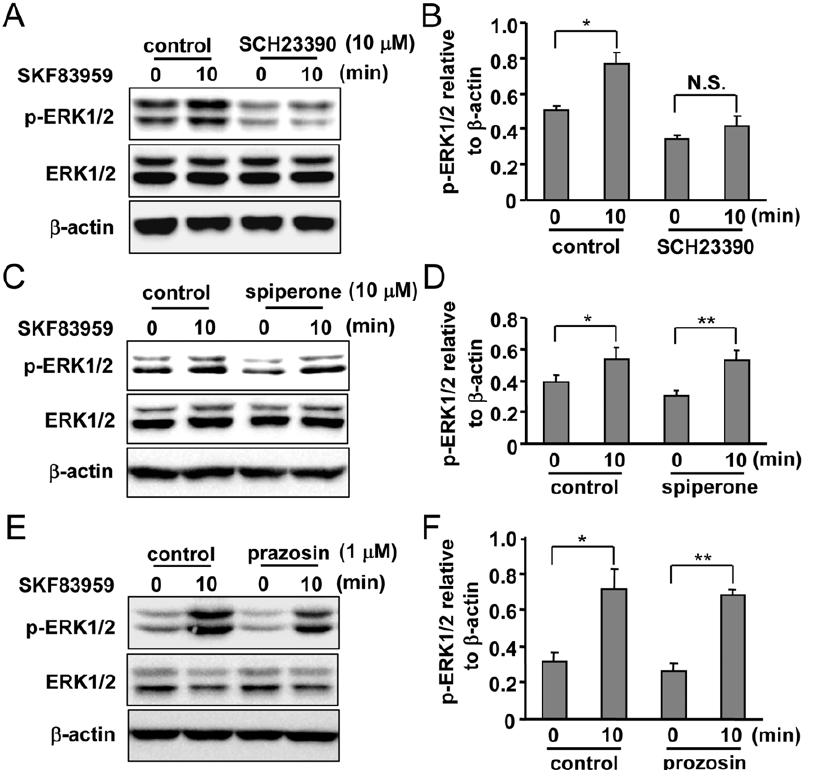
Figure 2. Involvement of putative PI-linked D 1 -like receptors in SKF83959-induced ERK1/2 phosphorylation. (A) Effects of D 1 dopamine receptor antagonist SCH23390 (10 m M, 30 min) on SKF83959 (30 m M, 10 min)-induced ERK1/2 phosphorylation. (B) Quantification of ERK1/ 2 phosphorylation level in astrocytes pre-incubated with SCH23390 and treated with SKF83959 (Mean 6 S.E., n=3, * P , 0.05, 10 min vs. 0 min). N.S.: no significance. (C) Effects of D 2 receptor antagonist spiperone (10 m M, 30 min) on SKF83959 (30 m M, 10 min)-induced ERK1/2 phosphorylation. (D) Quantification of ERK1/2 phosphorylation level in astrocytes pre-incubated with spiperone and treated with SKF83959 (Mean 6 S.E., n=3, ** P , 0.01 or * P , 0.05, 10 min vs. 0 min). (E) Effects of a -adrenoceptor antagonist prazosin (1 m M, 30 min) on SKF83959 (30 m M, 10 min)-induced ERK1/2 phosphorylation. (F) Quantification of ERK1/2 phosphorylation level in astrocytes pre-incubated with prazosin and treated with SKF83959 (Mean 6 S.E., n=3, ** P , 0.01 or * P , 0.05, 10 min vs. 0 min).